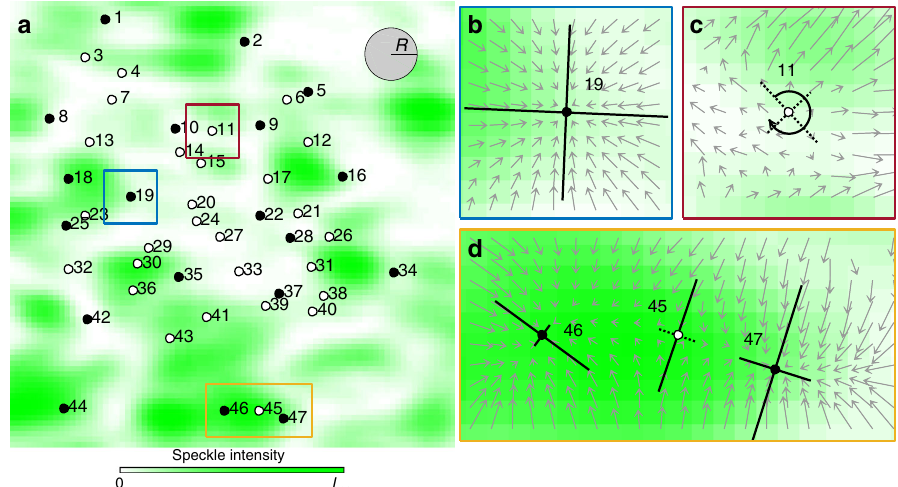
Fig. 5 Reconstruction of the equilibrium points in a speckle pattern. a The intensity of the speckle (green background, laser wavelength λ = 532 nm) is approximately proportional to the potential depth of the optical potential felt by a particle whose size (particle diameter 1.00 ± 0.04 μ m) is similar to the speckle characteristic size (2.8 μ m) 27, 30 . FORMA identi fi es several stable (full circles) and unstable (empty circles) equilibrium points, and measures